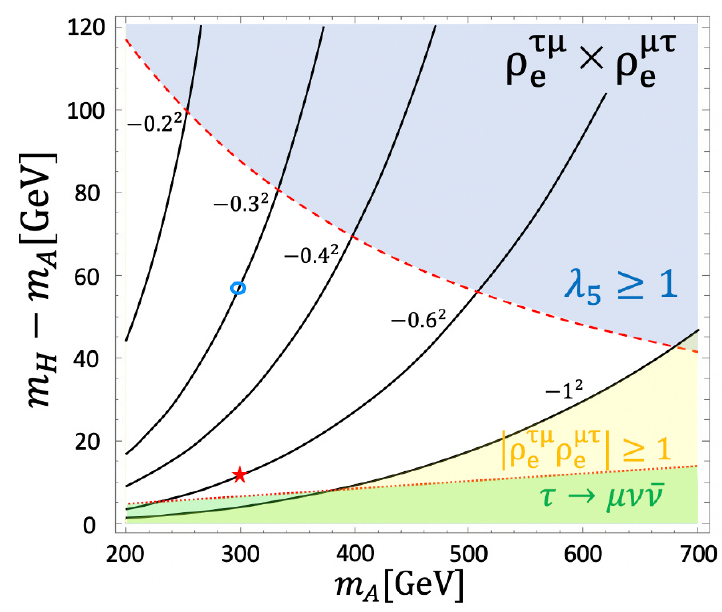
Figure 1 . The required value of (cid:26) (cid:22)(cid:28) (cid:2) (cid:26) (cid:28)(cid:22) to obtain (cid:14)a (cid:22) = 2 : 8 (cid:2) 10 (cid:0) 9 . The gray shaded region e e corresponds to (cid:21) 5 (cid:21) 1. The green shaded region is excluded by the (cid:28) ! (cid:22)(cid:23) (cid:22) (cid:23) process mediated by the charged Higgs where we assumed m = m H . The yellow shaded region corresponds to H (cid:6) j (cid:26) (cid:22)(cid:28) (cid:26) (cid:28)(cid:22) j (cid:21) 1. The benchmark points adopted for the LHC study in the following section are e e indicated by the blue circle (BP1) and the red star